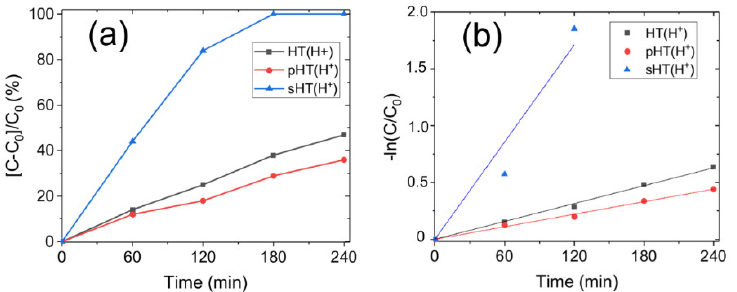
Figure 7. MO removal (%) by each HT sample versus irradiation time ( a ) and kinetic curves ( b ) for photocatalytic processes, considering C = C 0 exp( −